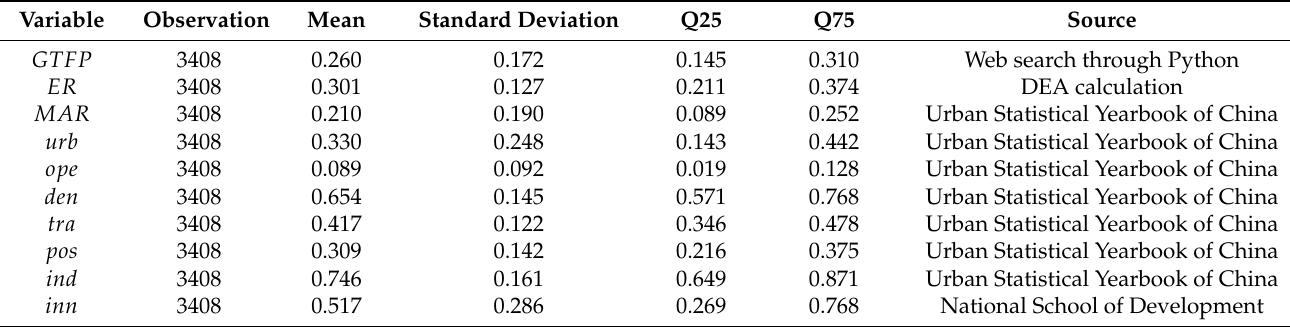
Table 1. Variable descriptive statistics and data